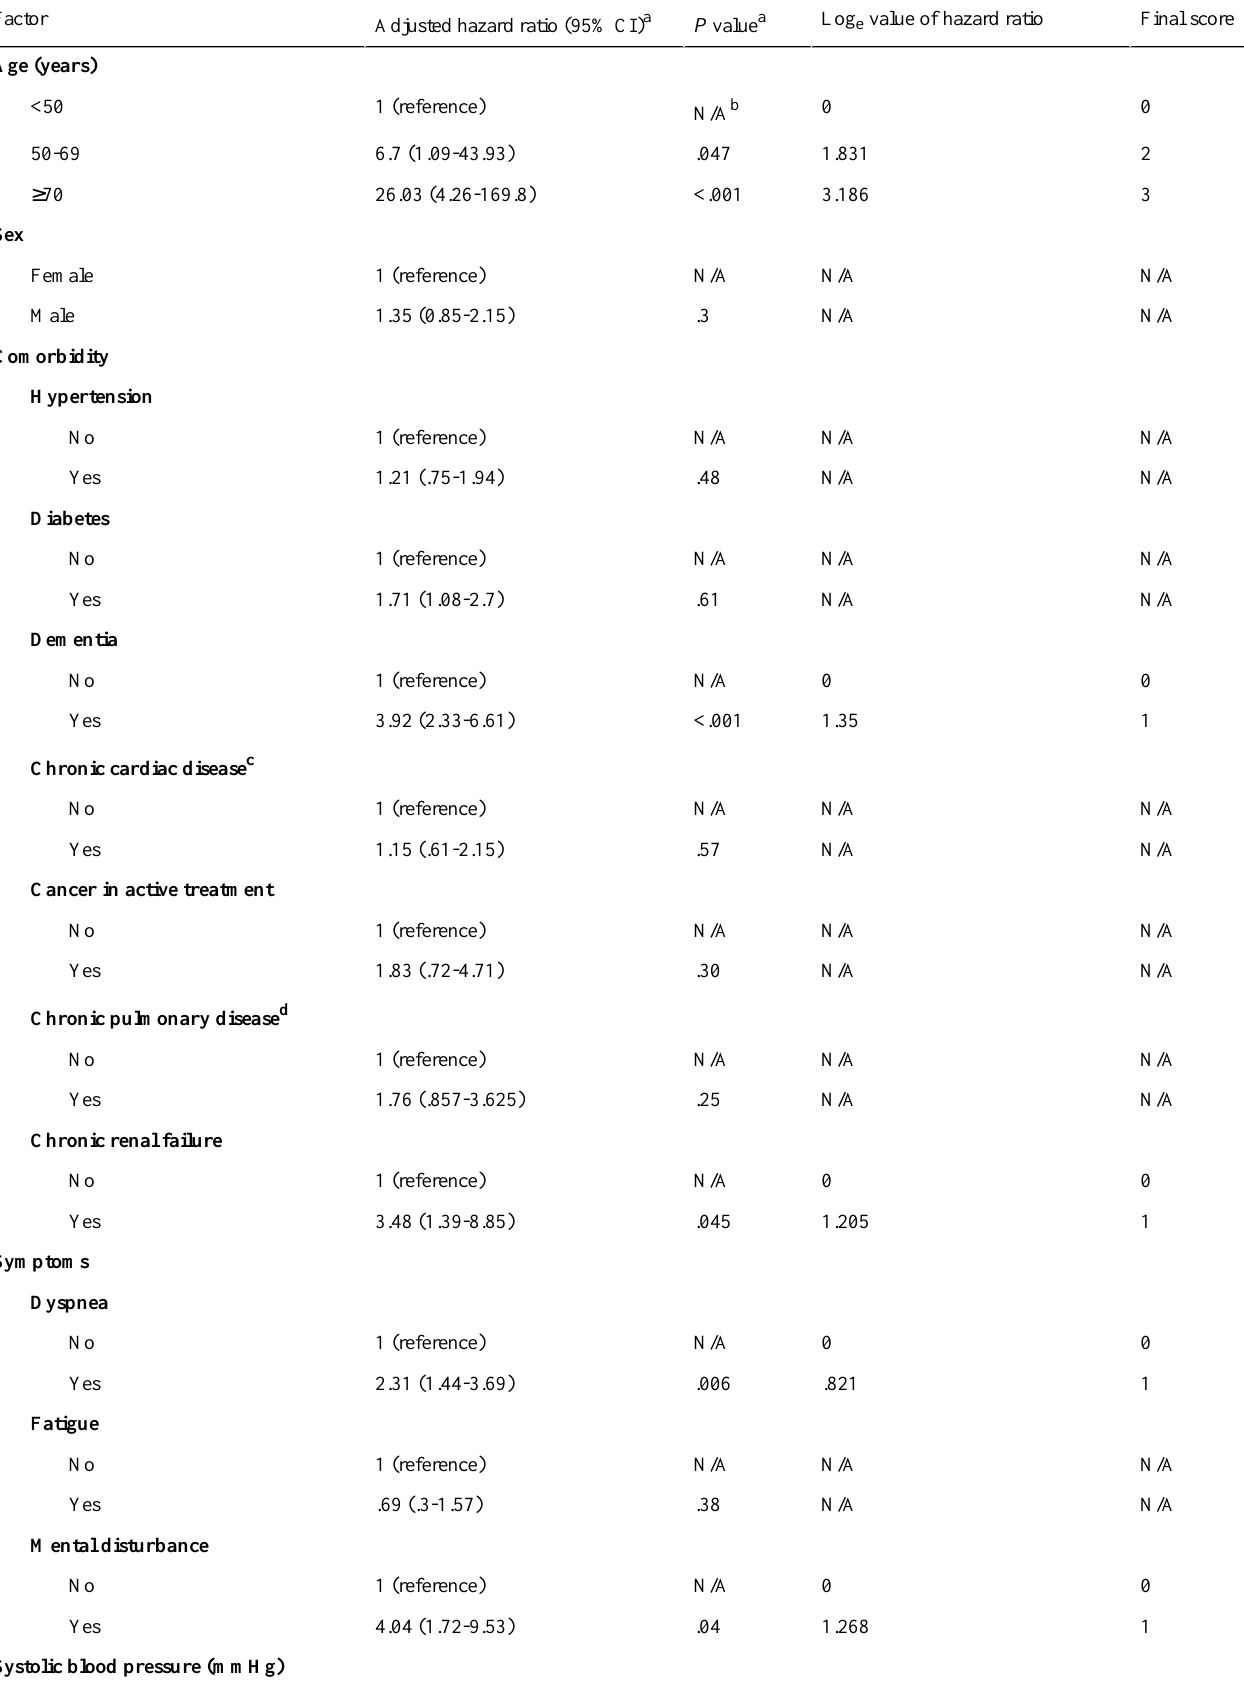
Table 3. The final scoring model in the development cohort. All values presented in the table represent data collected at the time of initial COVID-19